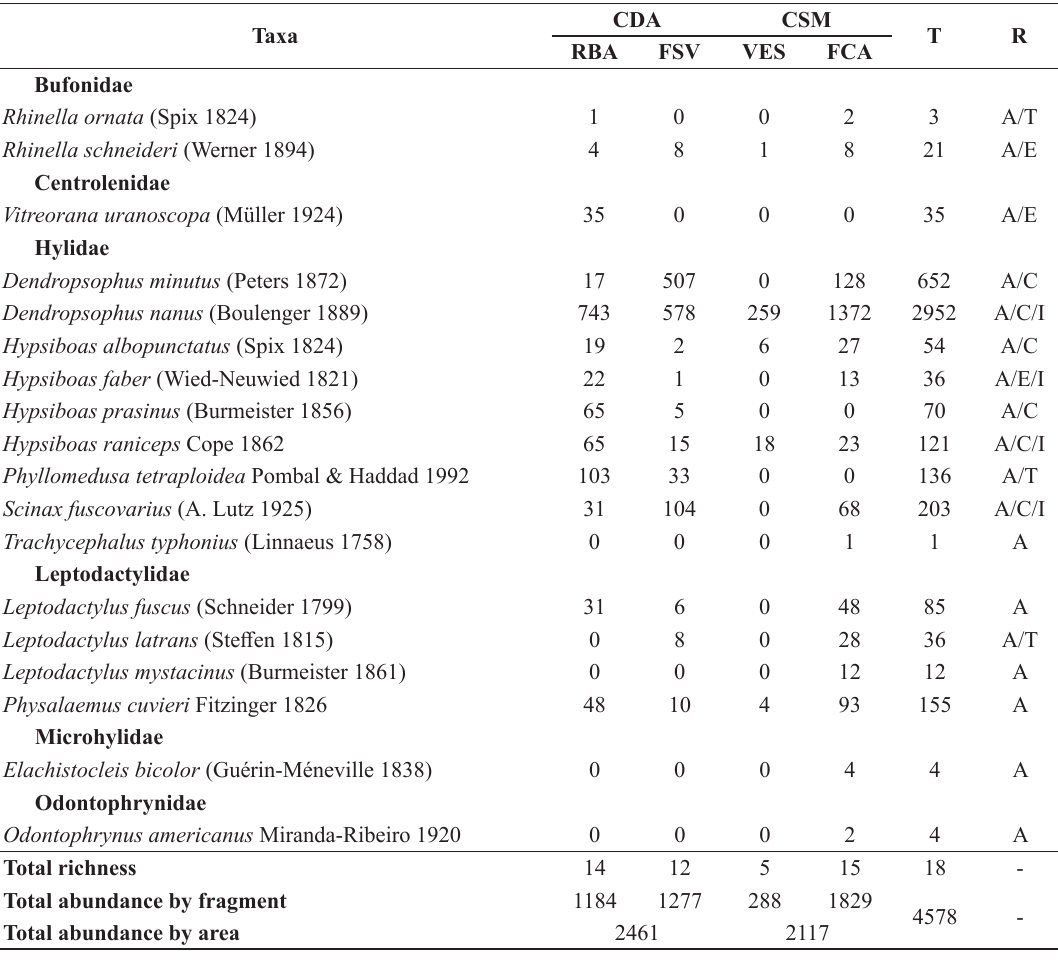
list of species registered in the areas CDa and CsM, located in the mid northern region of the state of Paraná, between September 2011 and March 2012; and total abundance of adult individuals by area and